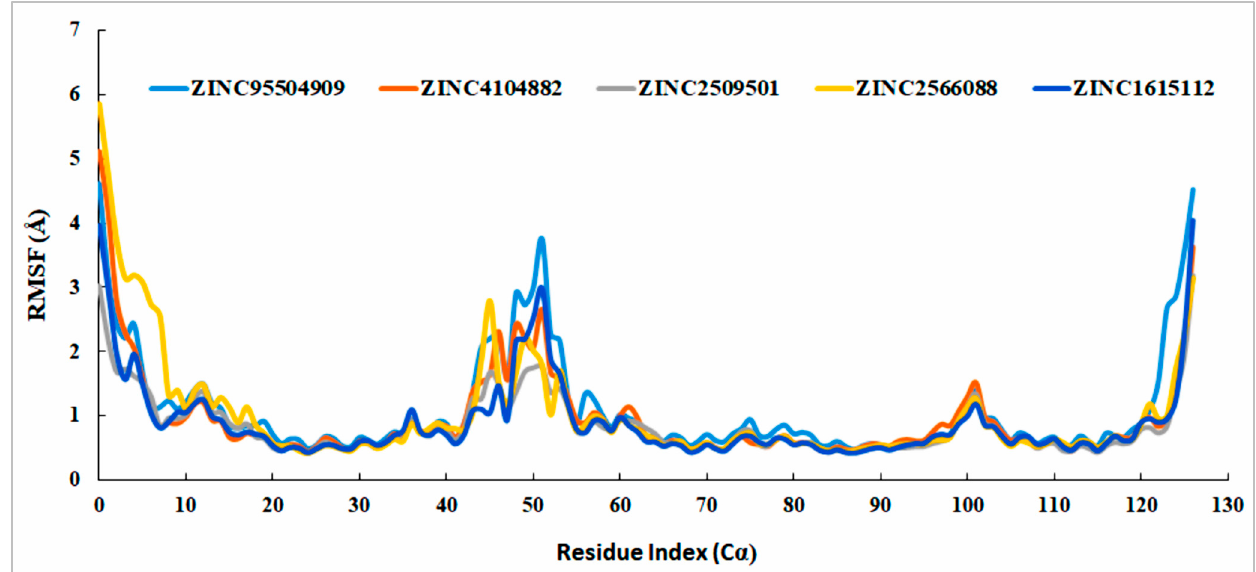
Figure 9. RMSF values of the all-natural compounds were determined from the protein C α atoms. Several colors indicated our natural compounds i.e., ZINC4104882 (orange), ZINC2509501 (gray), ZINC2566088 (gold), ZINC1615112 (blue), and control ligand ZINC95504909 (light blue).